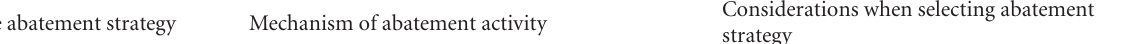
Table 1: Methane abatement strategies, mechanism of abatement, and considerations for